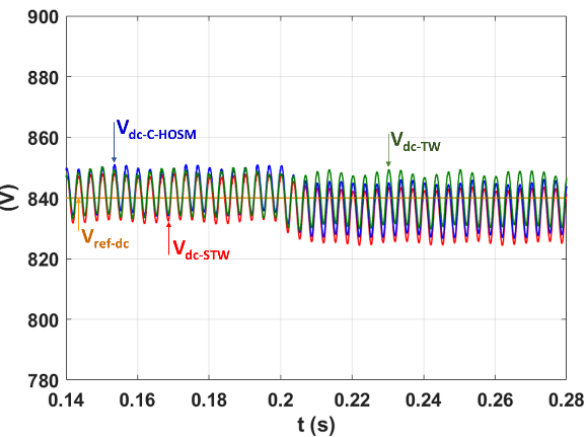
Figure 11. DC voltage using the C-HOSM, twisting, and super-twisting controllers.